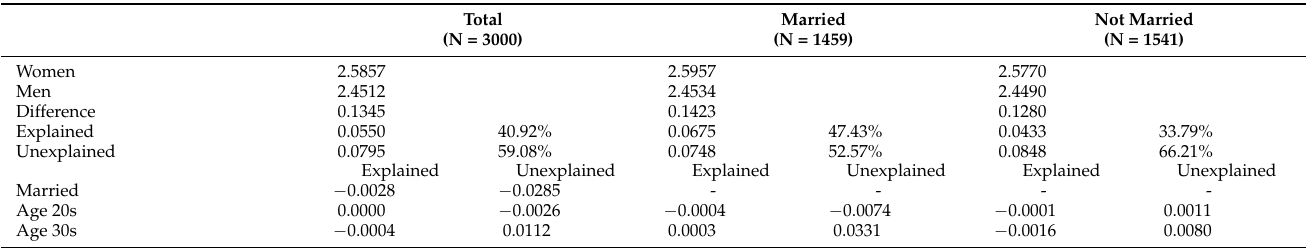
Table A2. Blinder-Oaxaca decomposition of the gender gap in